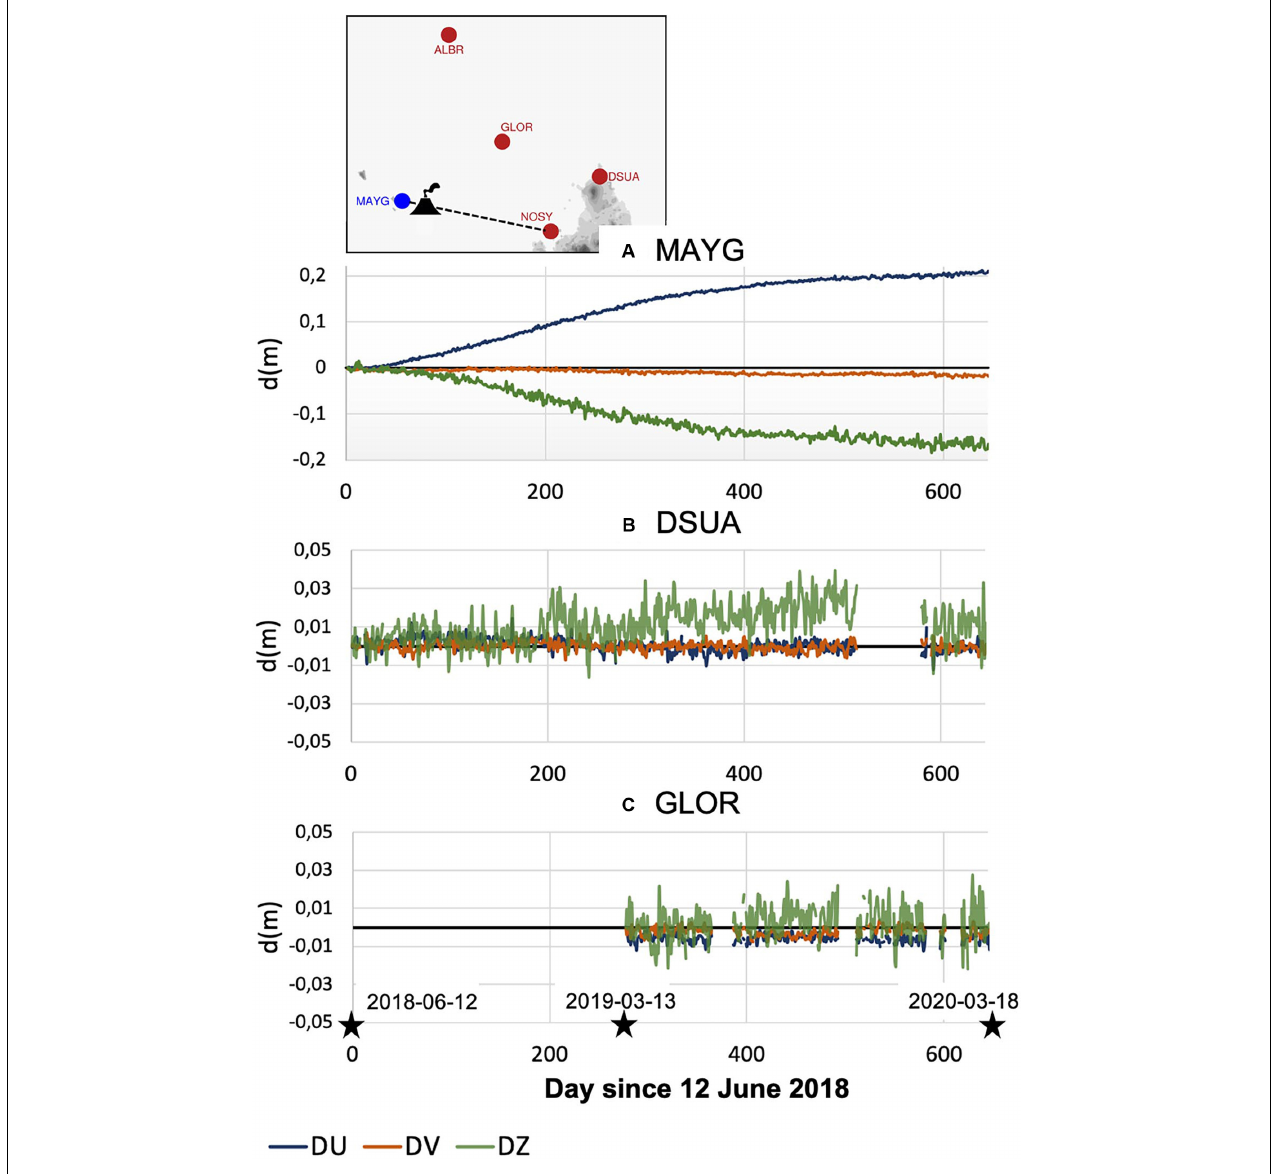
FIGURE 4 | Eastward (blue), southward (orange), and vertical (green) ground displacements with plate velocity removed as recorded by GNSS stations of (A) Mayotte (MAYG), (B) Diego-Suarez (DSUA) and (C) Grande Glorieuse, between June 12, 2018 and March 3, 2020. The insert shows the position of GNSS stations discussed in the text (in red: IOGA 4 MET stations, in blue: IGS station) as well as the location of the submarine volcano discovered in May 2019 [12.54 (cid:48) S, 45.43 (cid:48) E]. Note the different vertical scales in (A–C)